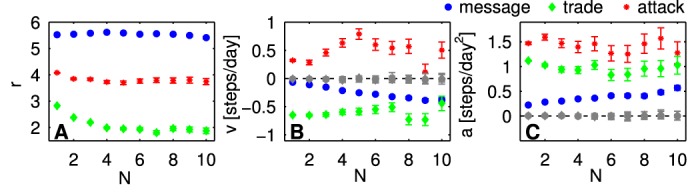
Average r
β, v
β, and a
β as a function of the number of interactions N
β.Errorbars are standard deviations of the mean. Randomized data are shown with gray symbols. For the randomized data r
β ∼ 12.1 for all interaction types and independent of the interaction strength (not shown). Characteristic distances are relatively constant in N
β, the characteristic convergence speed for communication increases with the number of messages. The separation speed for attacks increases up to N
attack ∼ 4 and remains constant afterward. Acceleration in positive direction, i.e. slowing of convergence for messages increases with N
message.